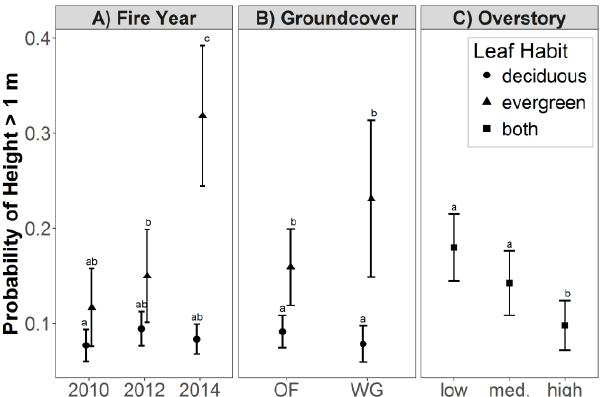
Figure 4. Probability of stem height >1 m (least-squares means with 95% confidence intervals) of shrub-form deciduous and evergreen hardwood trees in longleaf pine woodland in SW Georgia. ( A ) Effects of leaf habit and fire year; ( B ) Effects of leaf habit and groundcover; and ( C ) Effect of overstory density. Within each panel, effects that do not share superscripted letters are significantly different at a 95% confidence level. Abbreviations: old-field; OF; wiregrass; WG; medium, med.